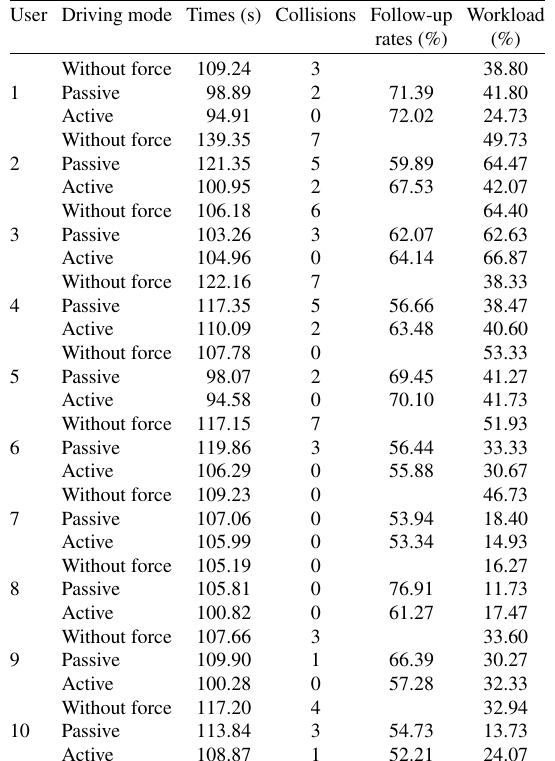
Table 4 Time averages, collisions, follow-up rates and workloads for the whole